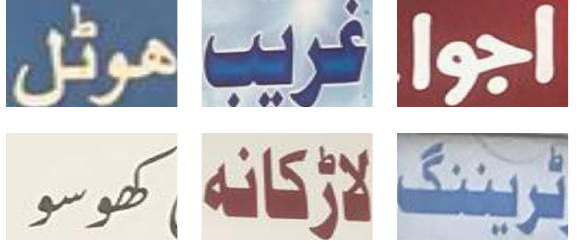
FIG 2. SOME URDU TEXT WORD-IMAGES WHICH ARE FORMED BY JOINING TWO OR MORE CHARACTERS